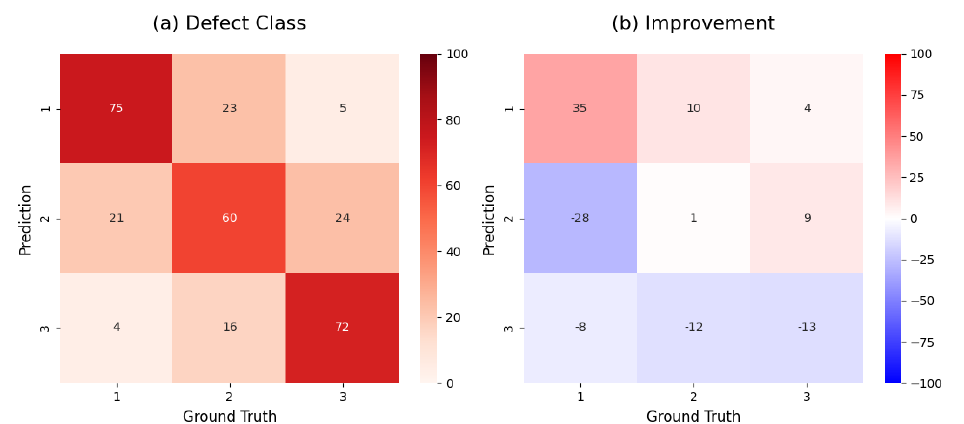
Figure 17. ( a ) Confusion matrix for the severity segmentation task using the multi-branch model with process parameters. The first chart shows that the accuracy has significantly improved over the model without the process parameters in Figure 14. ( b ) Improvement compared to the model without the process parameters. The chart shows a significant increase for severity level 1, while severity level 3 has a slight accuracy drop, showing an increase in confusion with level 2 severity